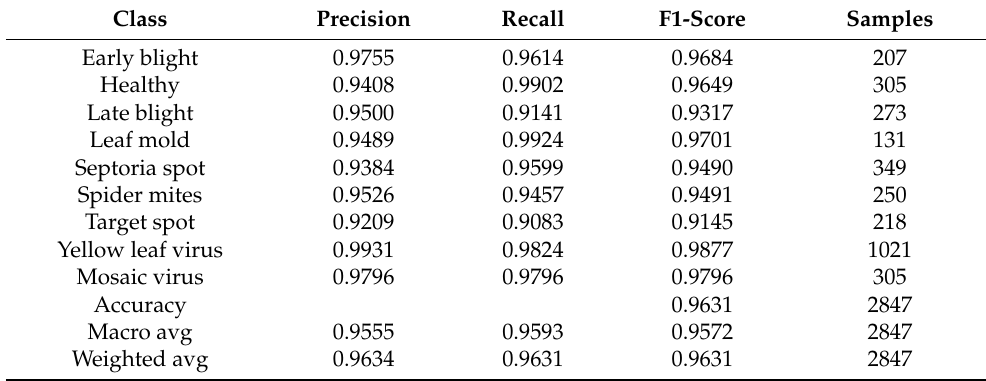
Table 5. Training results for the MobileNet